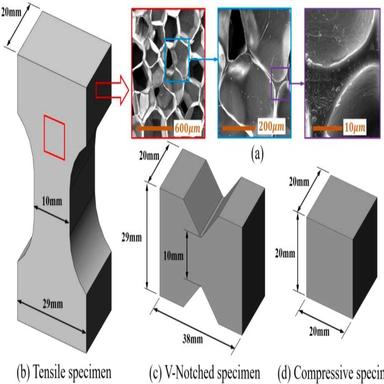
The meso-structure and geometry of PMI foam specimens. (a) SEM image of meso-structures of PMI foam (0.075 g/cm3 ); (b) Specimen's geometry for uniaxial tensile test; (c) Specimen's geometry for shear, combined tension-shear and compression-shear tests; (d) Specimen's geometry for uniaxial compression test.